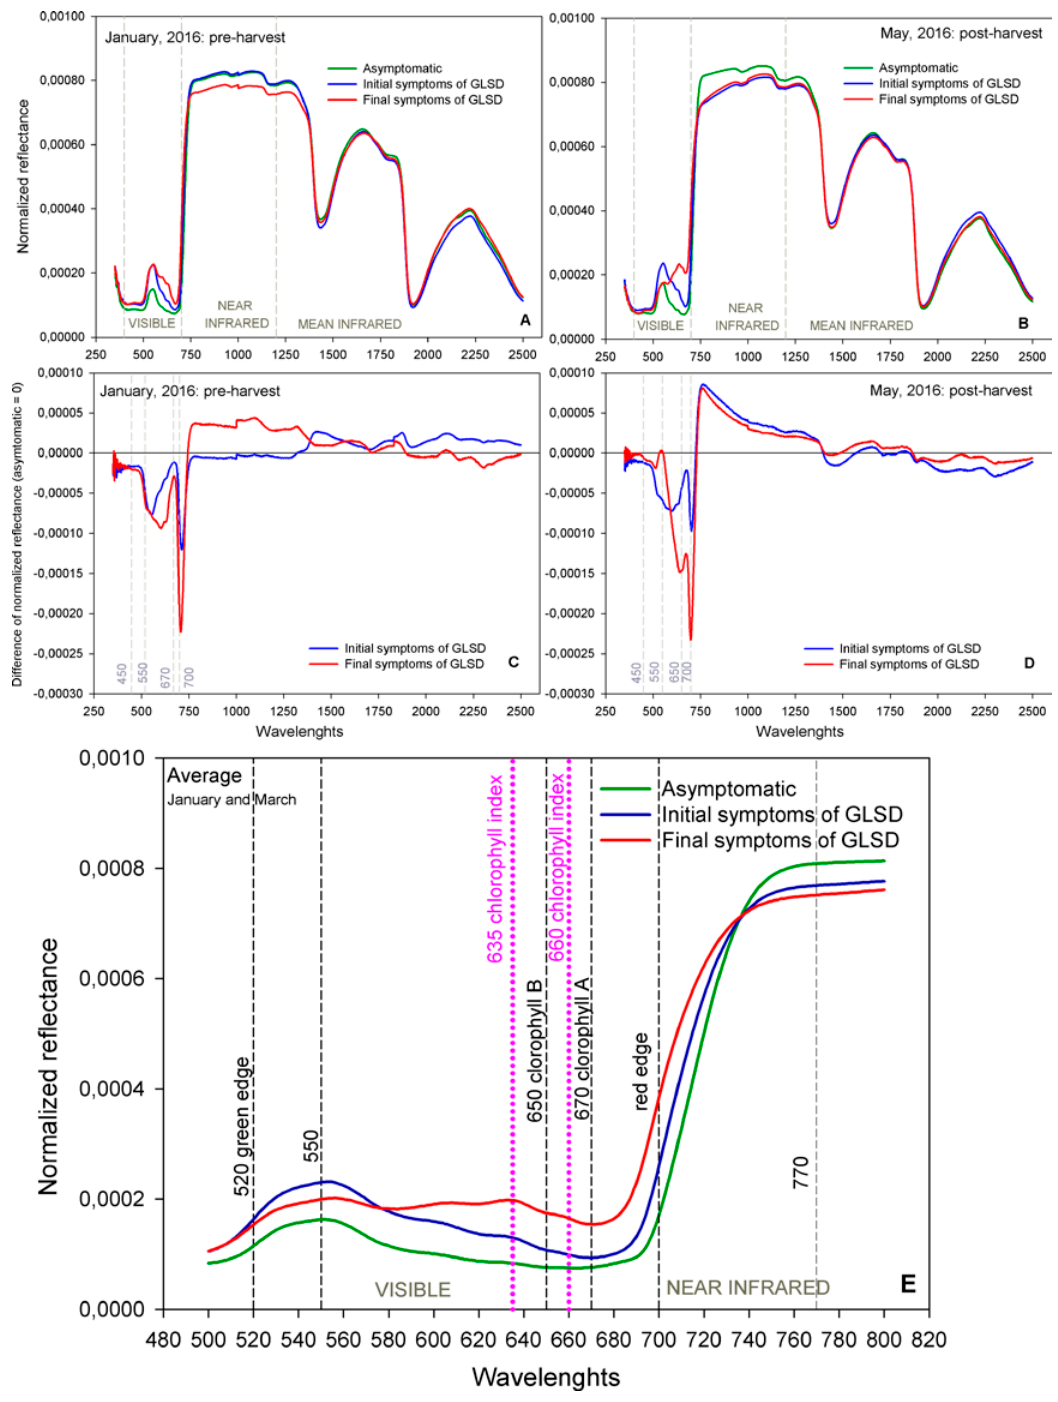
Figure 2. Spectral behaviour of asymptomatic grapevine leaves and with initial and final symptoms of grapevine leaf stripe disease (GLSD): normalized reflectance and difference of reflectance (250 to 3,500 nm) in January (A and C) and March (B and D); and normalized reflectance (500 to 800 nm) from asymptomatic and symptomatic GLSD grapevine leaves in aver- age of these two